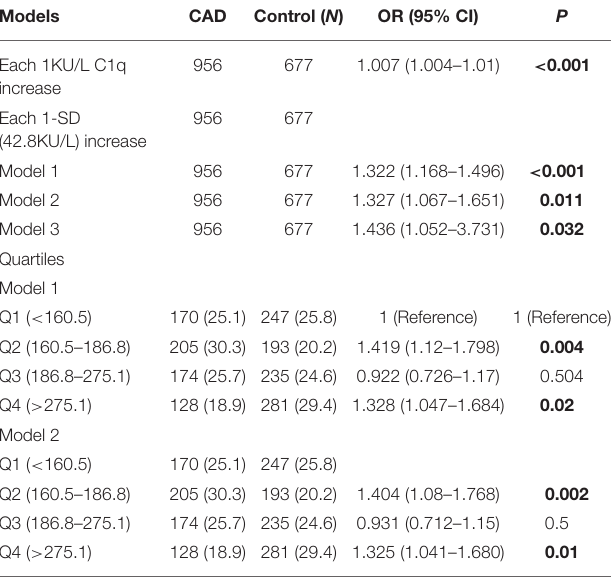
TABLE 2 | Associations of C1q with 14 cardiovascular biomarkers in CAD patients.